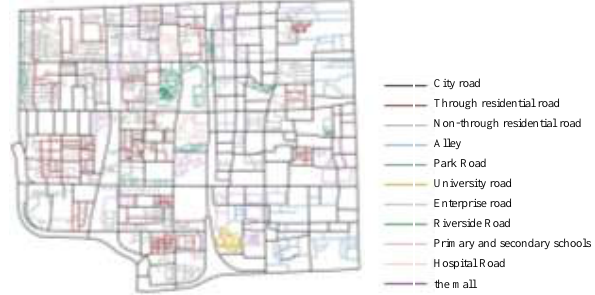
Figure 5. Street type Analysis of Nanlishi